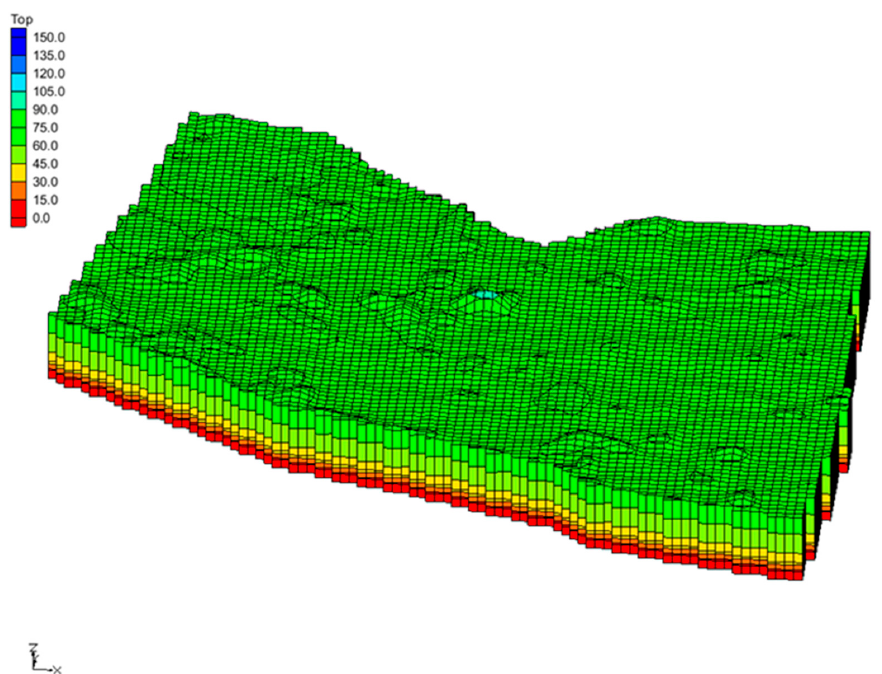
Figure 7. Three-dimensional structural model of the simulation area (vertical exaggeration 5 × ).